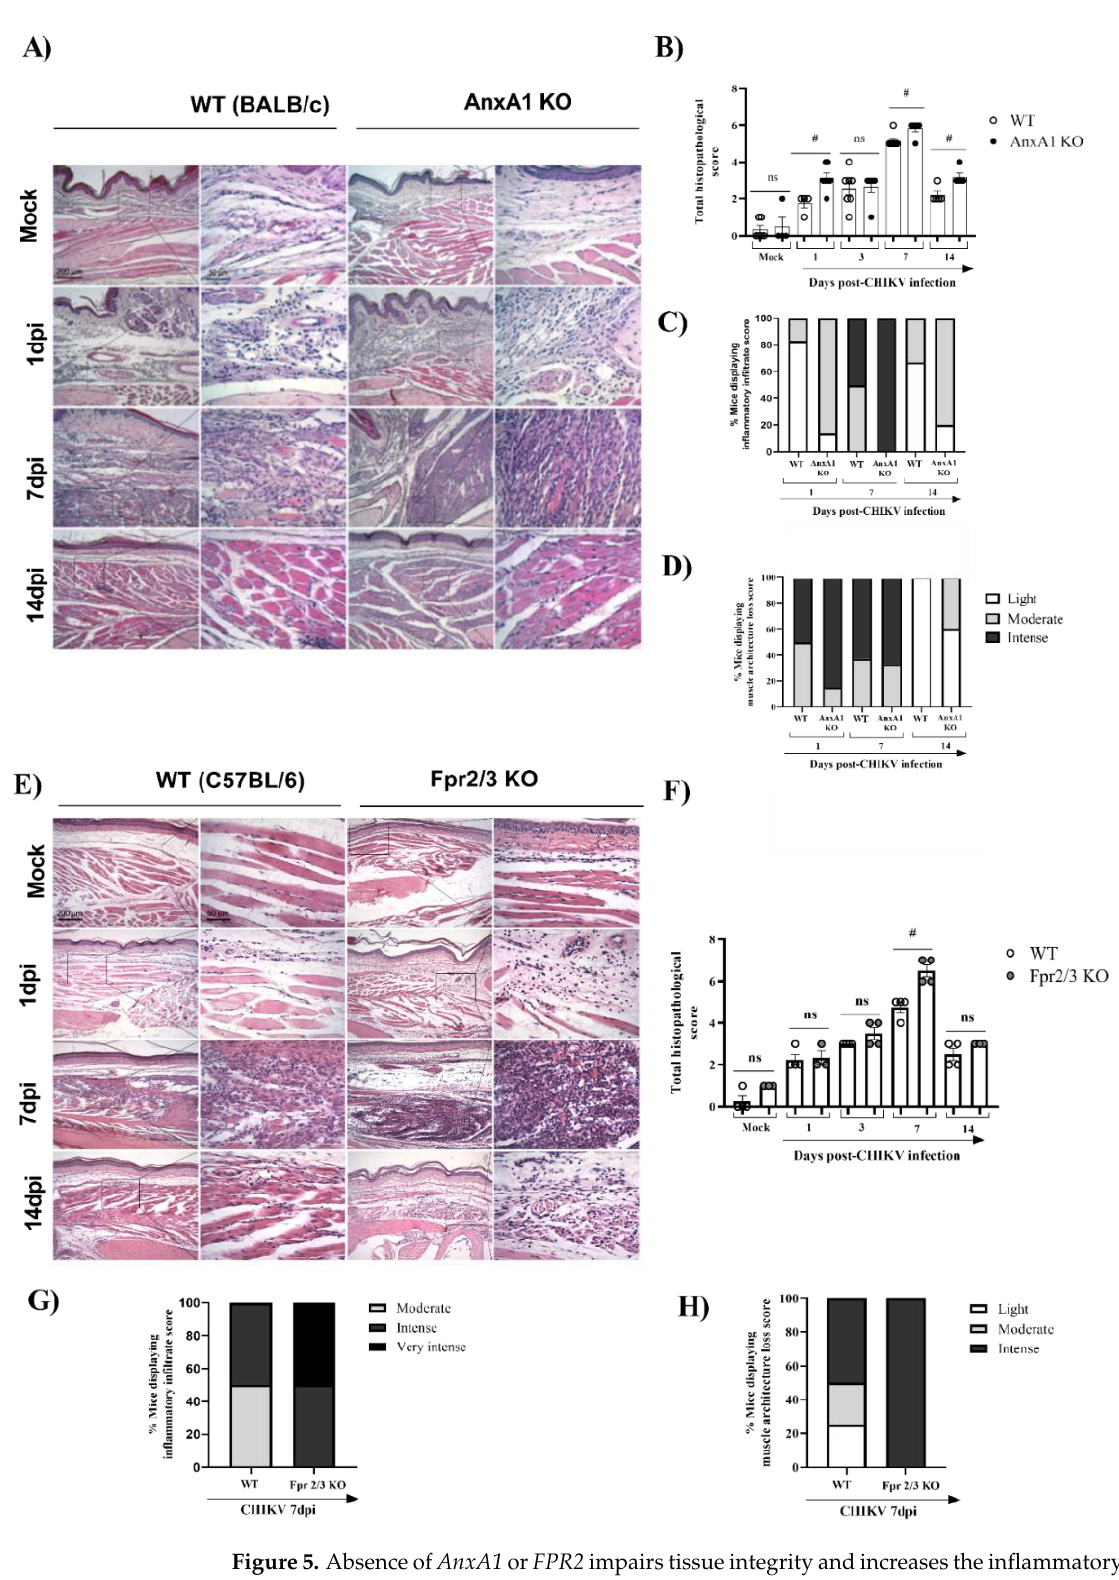
Figure 5. Absence of AnxA1 or FPR2 impairs tissue integrity and increases the inflammatory response in the paw of mice infected with CHIKV. AnxA1 KO or WT (BALB/c), and FPR2 ( Fpr2/3 KO) or WT (C57BL/6) mice were infected with CHIKV (10 6 PFU/30 µ L, i.pl.) and then were euthanized at 1, 3, 7 or 14 days post-infection. ( A , E ) Representative H&E images (magnification 100 × or 400 × . Scales: 200 µ m at low magnification and 50 µ m at high magnification) of inflamed joint footpads of mice. ( B , F ) Total histopathological scoring of inflammatory infiltrate, and tissue damage in the joint footpad. ( C , D , G , H ) show the percentage of mice presenting the score of inflammatory infiltrate or loss of muscle architecture in paw. Data are representative of two independent experiments, ( n = 3 – 4). Statistical anal- ysis was performed using the Mann – Whitney test. The AnxA1 KO or Fpr2/3 KO group was consid- ered statistically significant from the WT group when # p < 0.05.